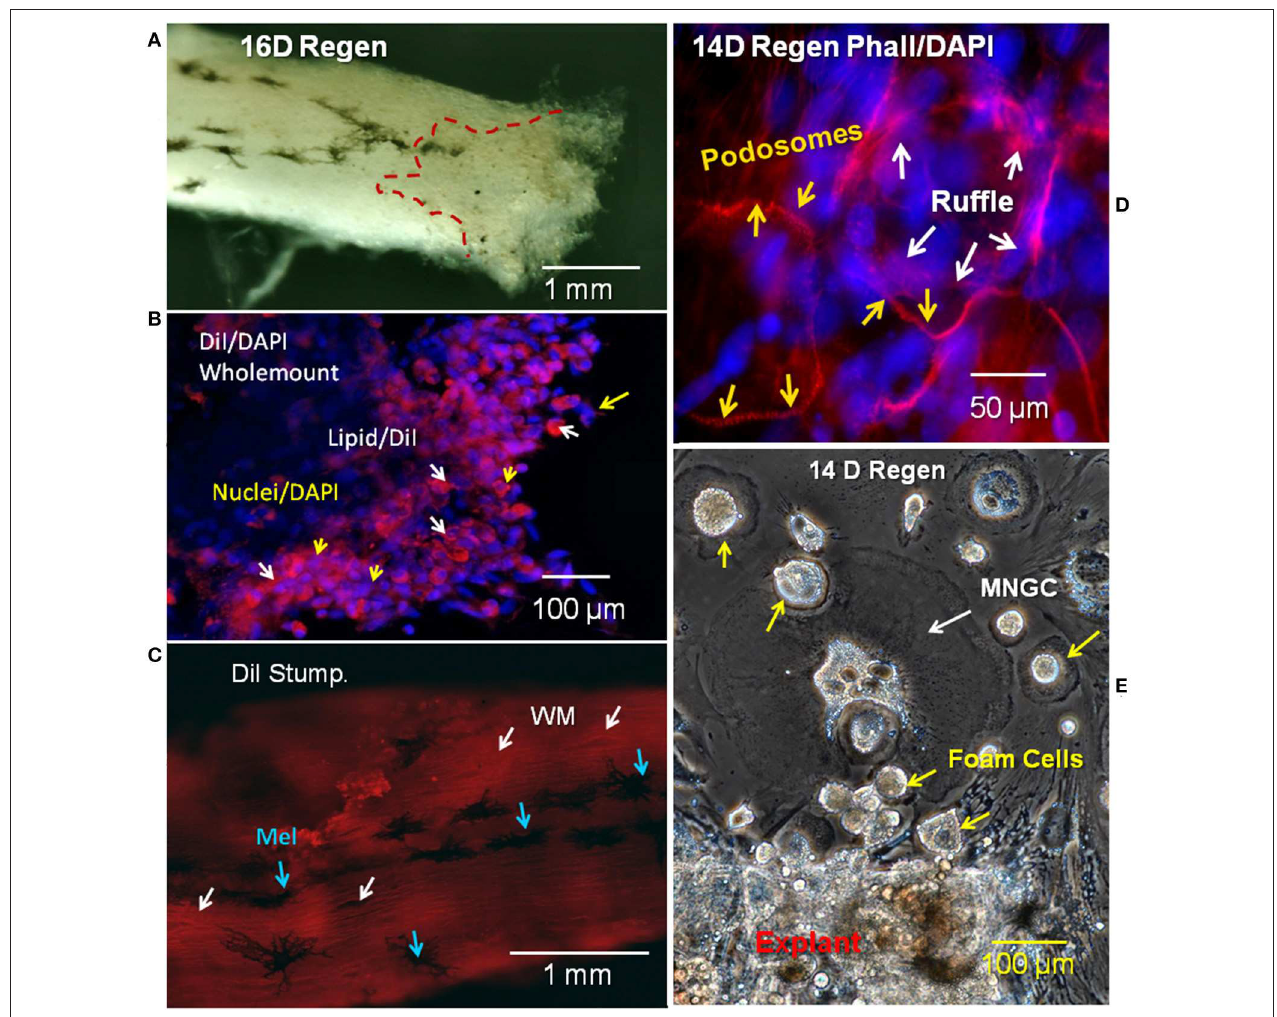
FIGURE 2 | Regenerating cord meninges MNGCs and foam cells. (A) Red dashed lines shows the region of regenerating outgrowth with lipid-laden cells in one side of a 16D spinal cord regenerate. (B) Lesioned wholemount cord from 16D regenerating cord dual-labeled with DiI (red/lipid) and DAPI (blue/nuclei). Lipid-laden cells are clustered near the regenerating end. White arrows show cells labeled with DiI and yellow arrows show labeled nuclei. (C) Image near the surface of 16D wholemount distal stump of a regenerating cord labeled with DiI. White arrows show white matter in axonal tracts, while blue arrows indicate surface melanocytes. (D) Regenerating 14D spinal cord wholemount labeled with rhodamine phalloidin (red/actin) and DAPI (blue/nuclei). Podosomes labeled with rhodamine phalloidin (yellow arrows) can be seen surrounding the nuclei of MNGCs. The ruffled border is indicated by white arrows. (E) Phase contrast image of unlabeled outgrowth from a 14D regenerate in culture 11 days. MNGCs were detected in the outgrowth (white arrows), in addition to foam cells (yellow arrows). Regen, regenerating; wm, white matter; mel, melanocyte; MNGC, multinucleated giant cells; DIV, days in vitro . Magnification bar is shown in the lower portion of each